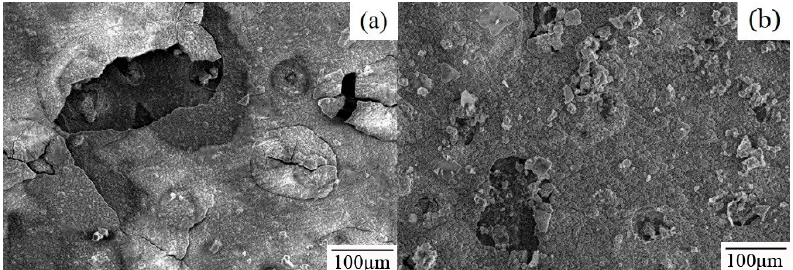
Figure 9. The corrosion products microstructure of 55AZS sample exposure for different days: ( a ) 30 days, and ( b ) 38 days.